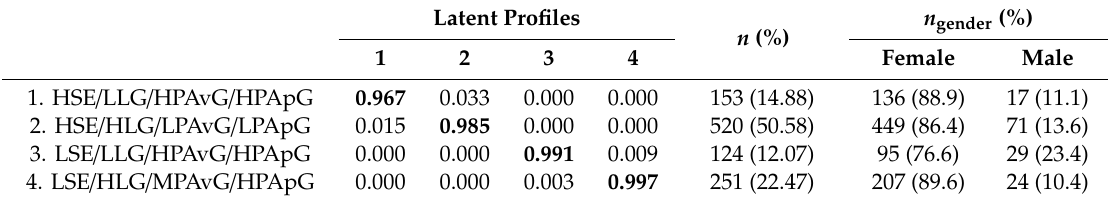
Table 3. Characterization of the latent profiles and classifying accuracy of the individuals in each